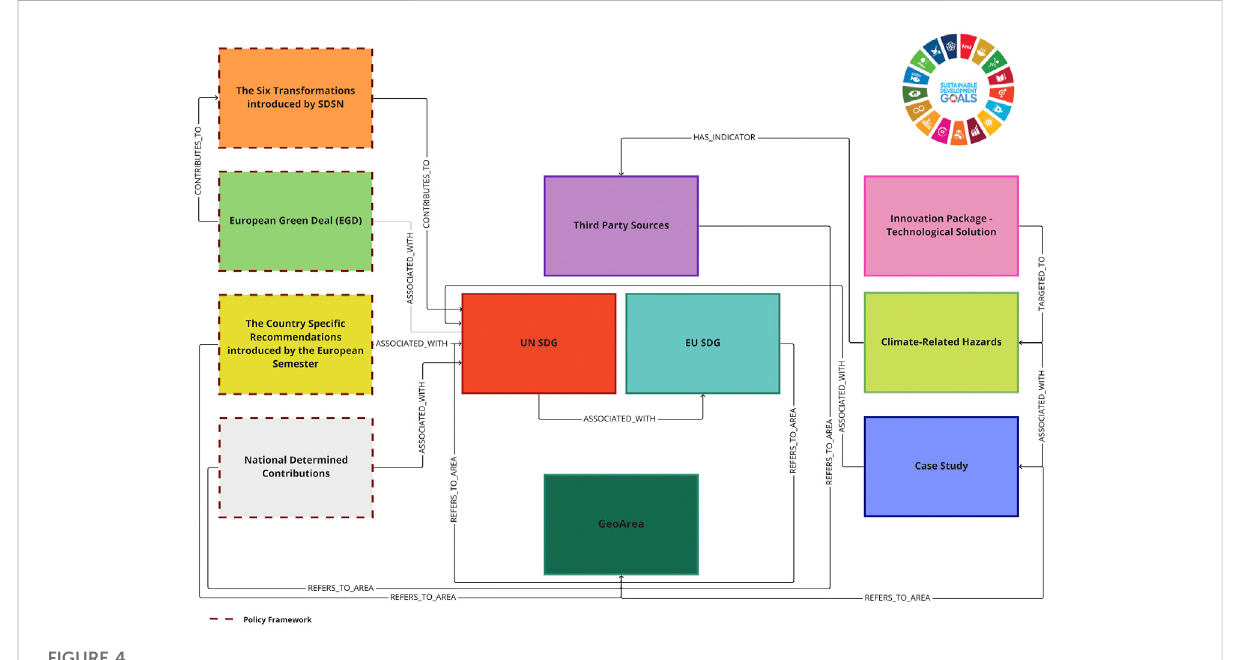
FIGURE 4 High level view of the